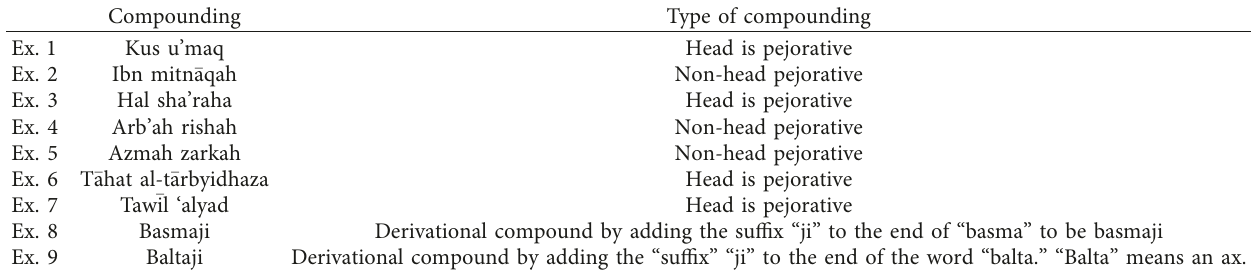
Table 2: Compounding (naht) and derivational